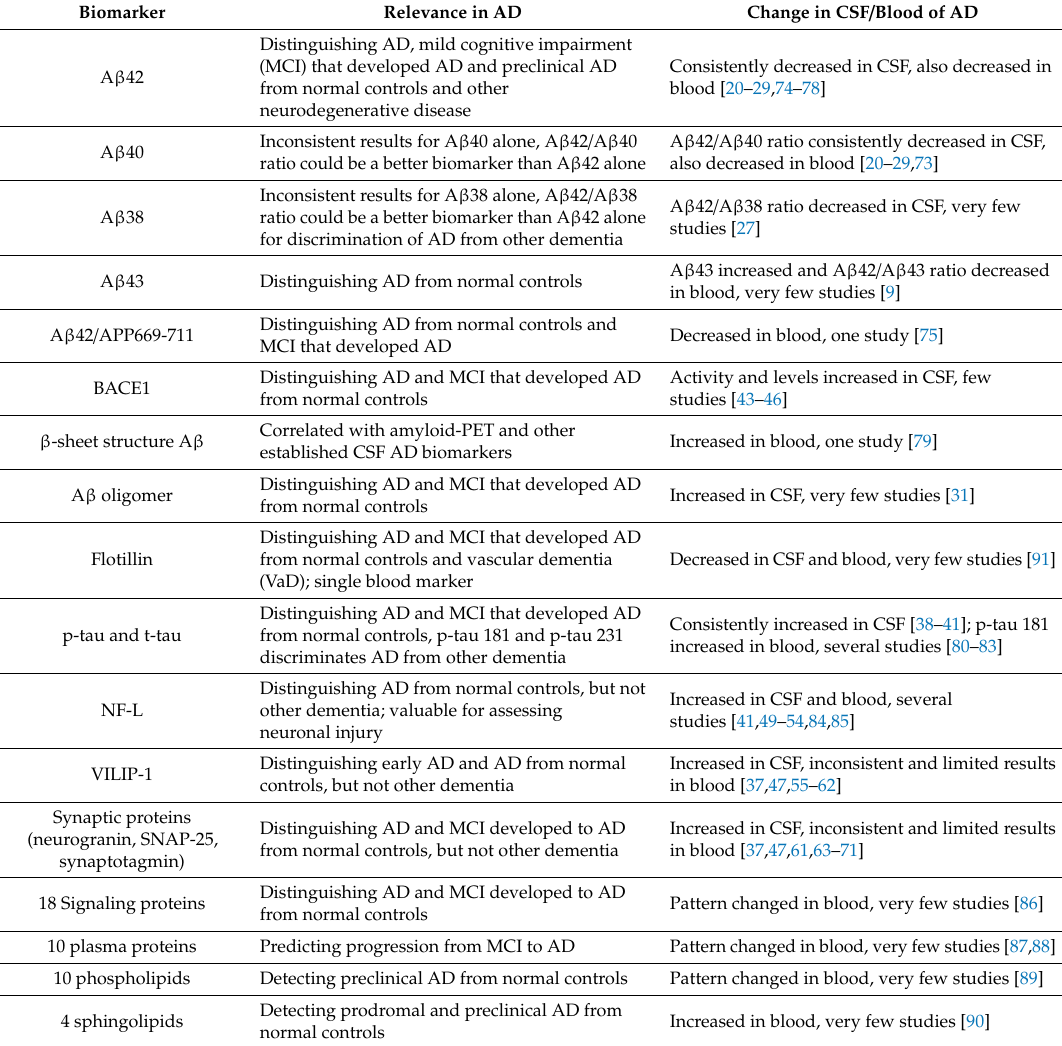
Table 1. Selected biomarkers of AD in cerebrospinal fluid (CSF) and blood.